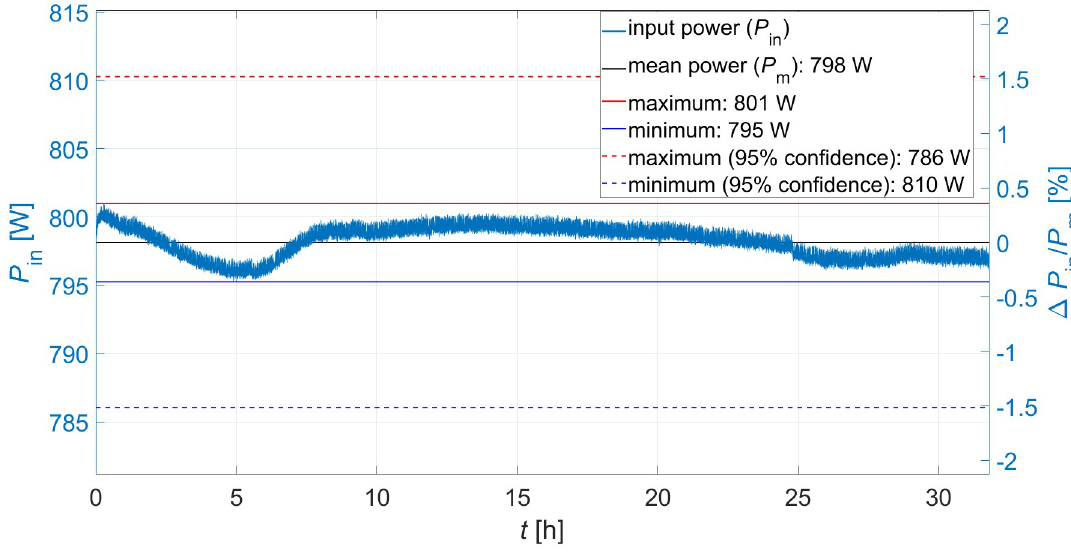
Fig 11. Input power stability measurement. Measuring time: 32